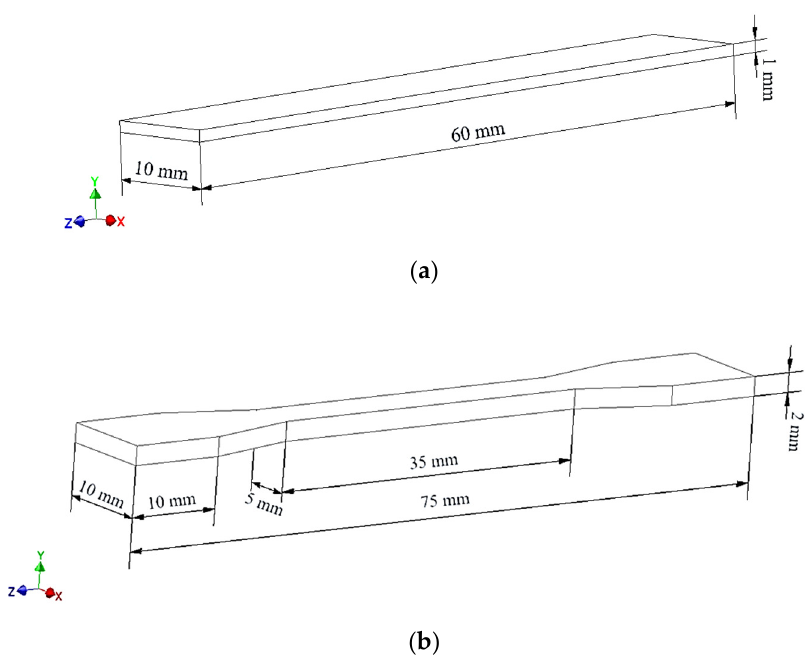
Figure 2. The dimensions of the samples, respectively: ( a ) a bar and ( b ) a paddle. The process parameters are summarized in Table 2. Table 2. Selected printing and injection parameters.